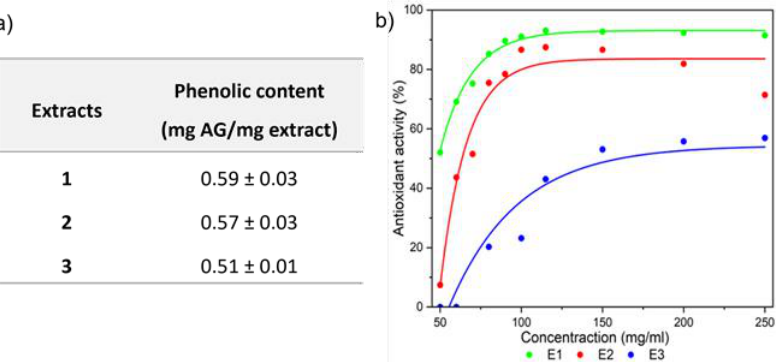
Figure 2. ( a ) Total phenolic content in mg GA (gallic acid)/mg extract present in the extracts; ( b ) antioxidant activity, expressed by the percentage of DPPH radical capture, of the three extracts tested in a concentration range of between 50 mg/mL and 250 mg/mL.